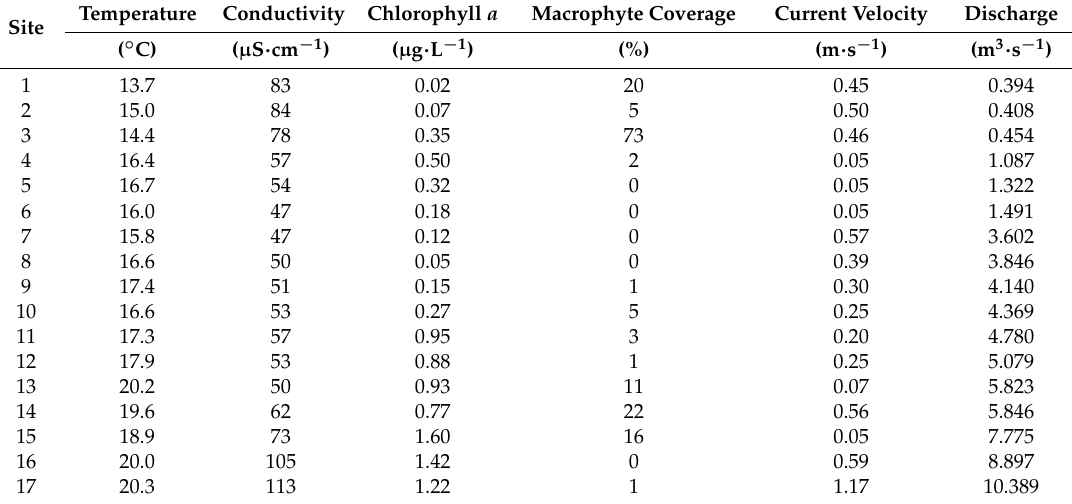
Table 1. Mean values of environmental factors measured at examined sites of the Corgo river.